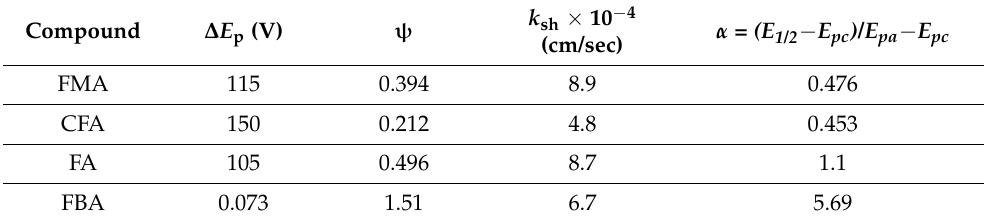
Figure 4. CVs of FMA showing scan rates effect. Table 2. Summary of important electrochemical parameters obtained for all